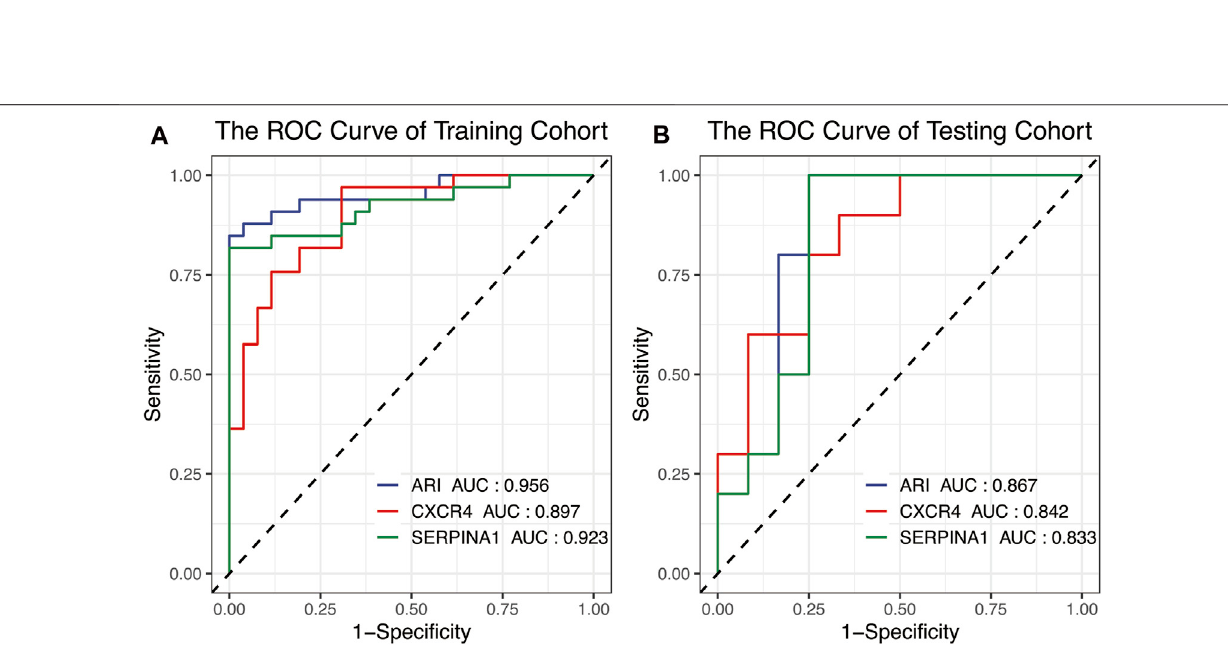
Frontiers in Genetics |